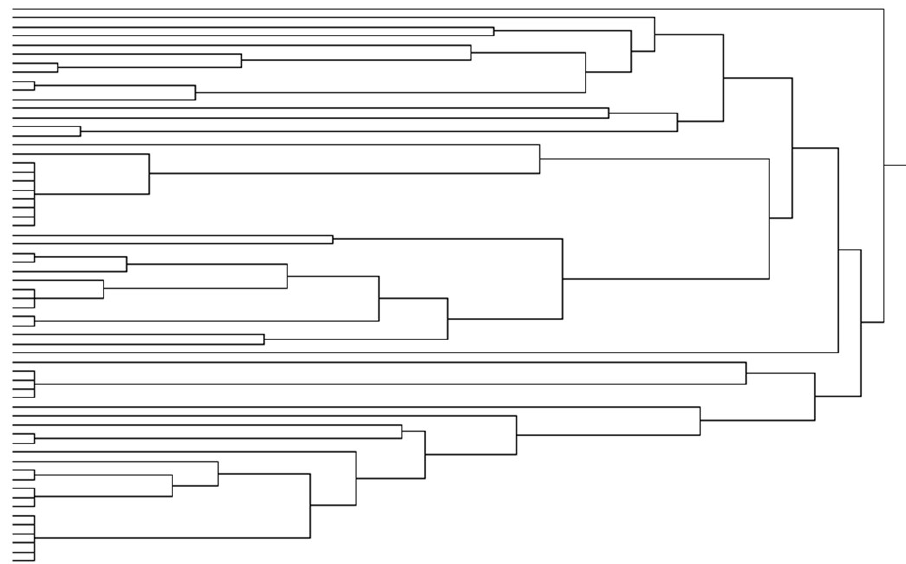
Figure 4. The REGE-based similarity dendrogram for the Gulf on Naples food web, shown in Figure 2. The sum of horizontal distances shows similarity of network positions: The path is shorter between similar nodes. Node identity is not shown (for technical reasons).